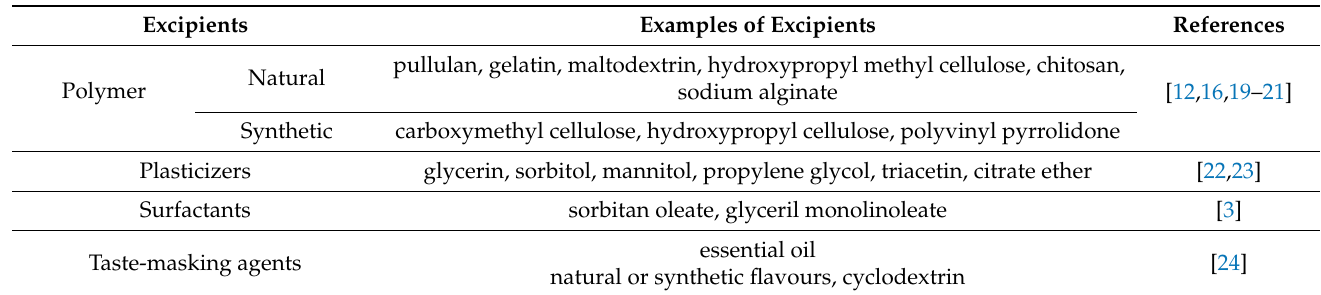
Table 2. Typical excipients used in orodispersible films (ODF)